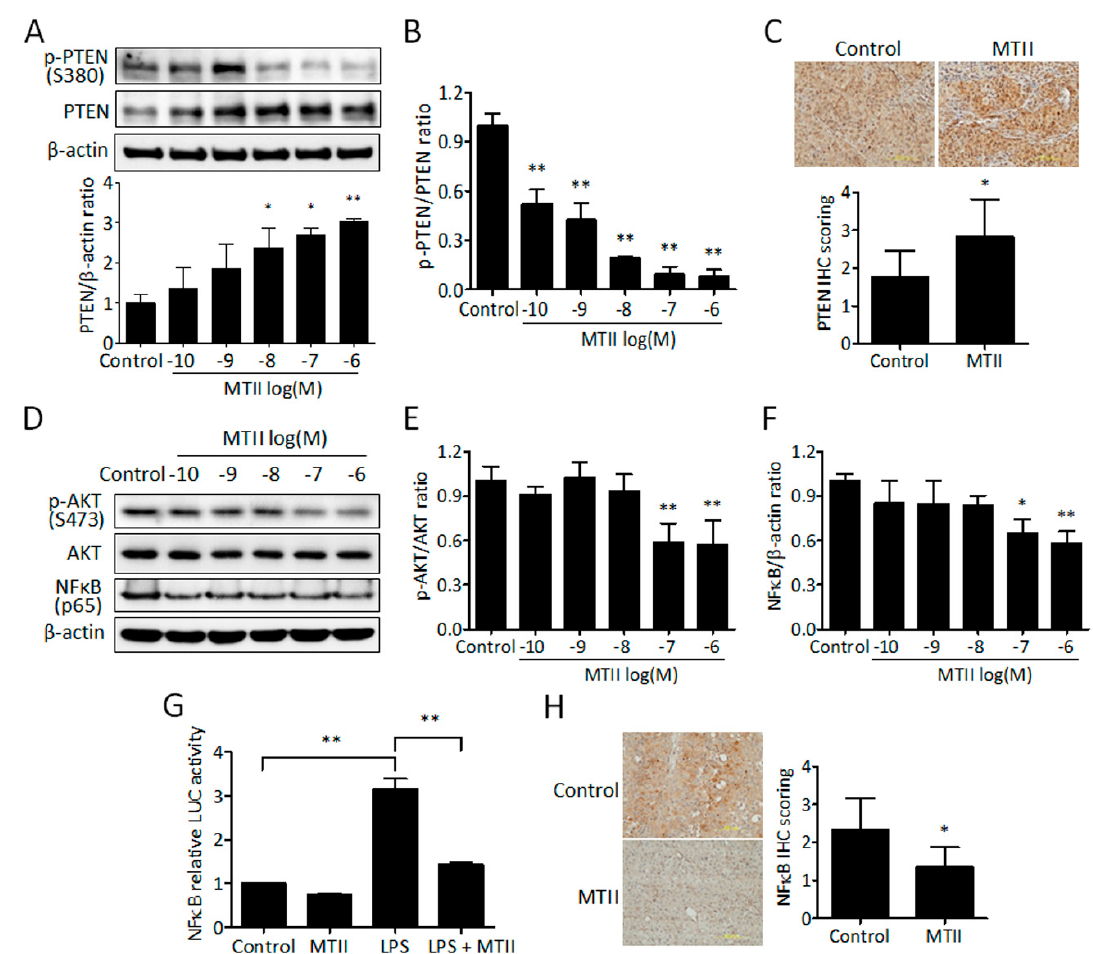
Figure 3. Effect of MTII peptide on the PTEN/AKT/NF κ B signaling pathway in melanoma. ( A ) After being incubated with MTII peptide for 24 h, cells were harvested and analyzed by Western blot analysis. The protein ratio of PTEN was normalized with β -actin by Image Pro-plus analysis software. ( B ) The p-PTEN/PTEN ratio was calculated using Image Pro-plus analysis software from duplicate experiments. The protein ratio of PTEN was normalized with β -actin by Image Pro-plus analysis software. Data was expressed as fold change ± SD of duplicate experiments. ( C ) IHC analysis of PTEN expression in control and MTII-treated melanoma tissues. Scale bar, 200 μ m. Data were calculated from different melanoma tissues and expressed as mean ± SD ( n = 6). ( D ) Western blot analysis of p-AKT, AKT and NF κ B (p65) in MTII-treated cells. β -actin was used for normalized protein level. ( E ) The p-AKT/AKT ratio was calculated using Image Pro-plus analysis software from duplicate experiments. ( F ) The protein ratio of NF κ B (p65) was normalized with β -actin by Image Pro-plus analysis software. Data were expressed as the fold change ± SD of duplicate experiments. ( G ) Cells were transfected with plasmids encoding a NF κ B luciferase report gene for 24 h and then treated with MTII peptide with or without LPS for another 24 h. NF κ B activities were measured and expressed as means ± SD from triplicate experiments. ( H ) IHC score analysis of NF κ B p65 expression in control and MTII-treated melanoma tissues ( n = 6). Scale bar, 200 μ m. *: p < 0.05, **: p < 0.01.